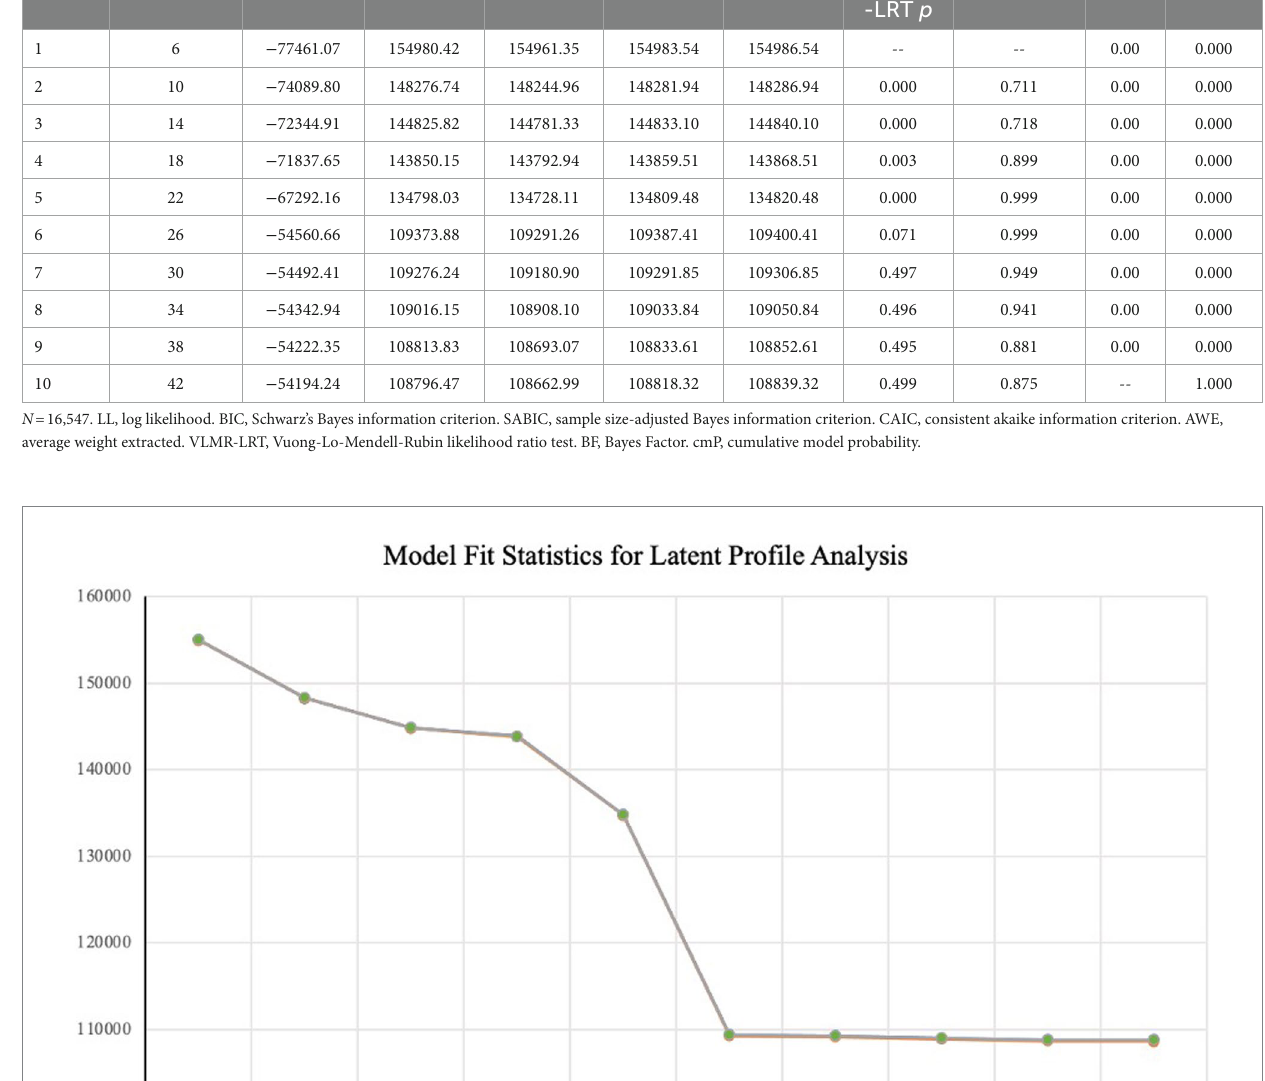
TABLE 2 Model fit statistics for latent profile analysis, by sample and profile solution. No. Params.